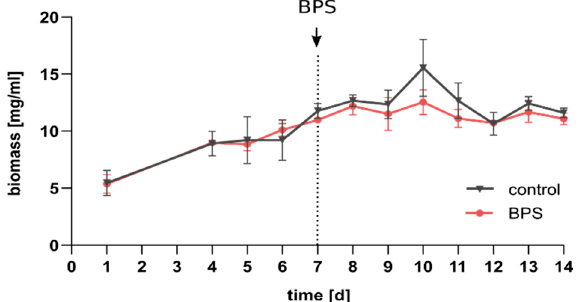
Figure 2. Bacterial growth of simplified human intestinal microbiota (SIHUMIx) indicated by biomass development (mean of n = 3 bioreactors).